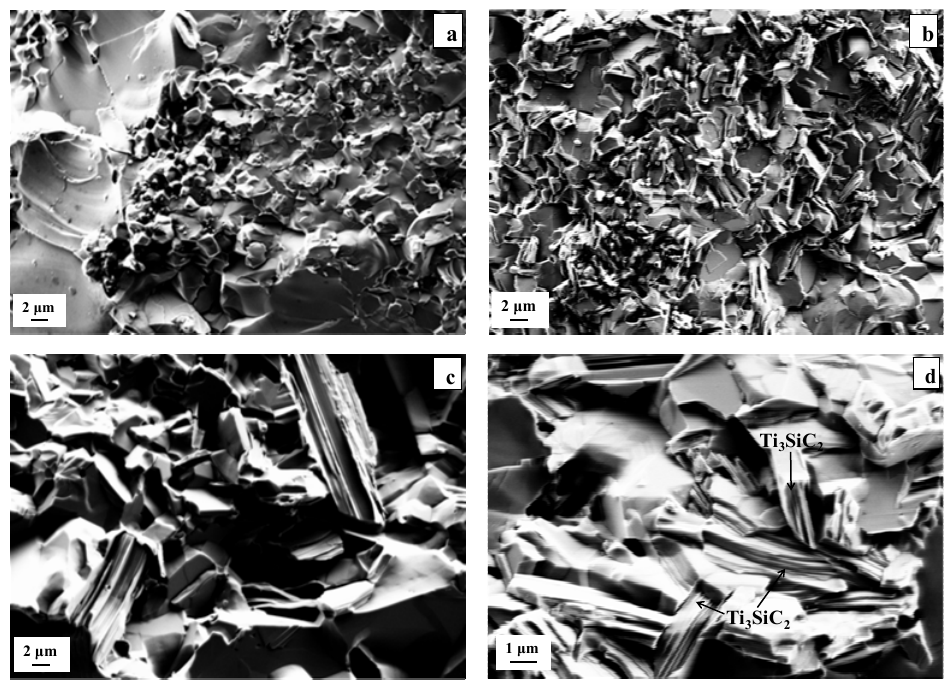
Fig. 13 FEG-SEM micrographs of the fracture surface of the bulk material obtained after sintering for 20 min at (a) 1300, (b) 1350, and (c) 1400 ℃ . (d) is a detail of (c) confirming the layered structure of Ti 3 SiC 2 .